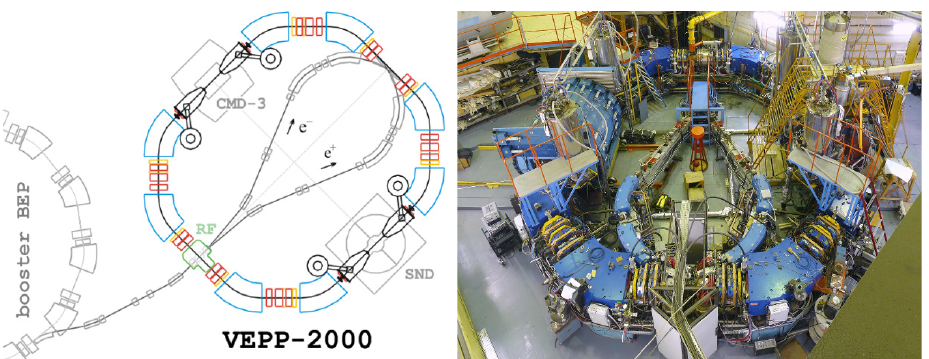
Fig. 4 VEPP-2000 layout and photo.